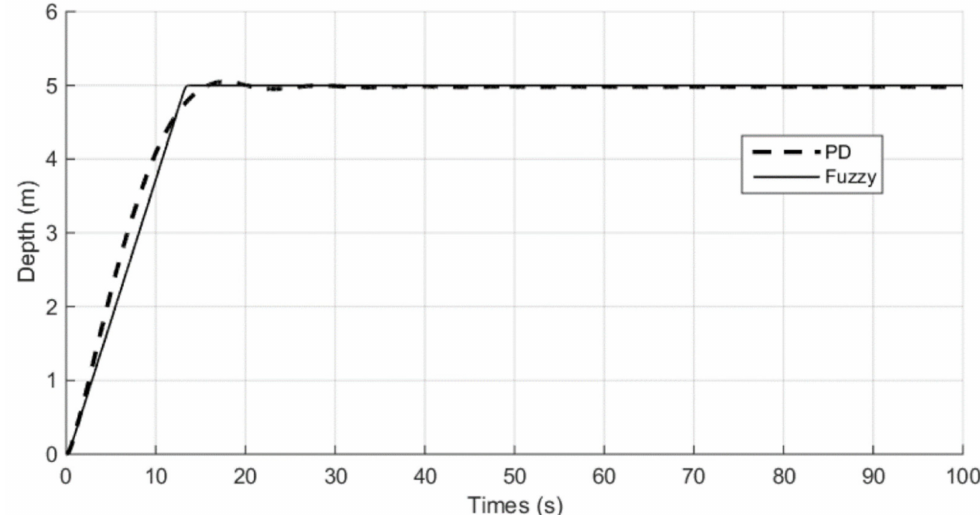
Figure 7. Graph of the given and the current depth of the AUV versus time without noise or external